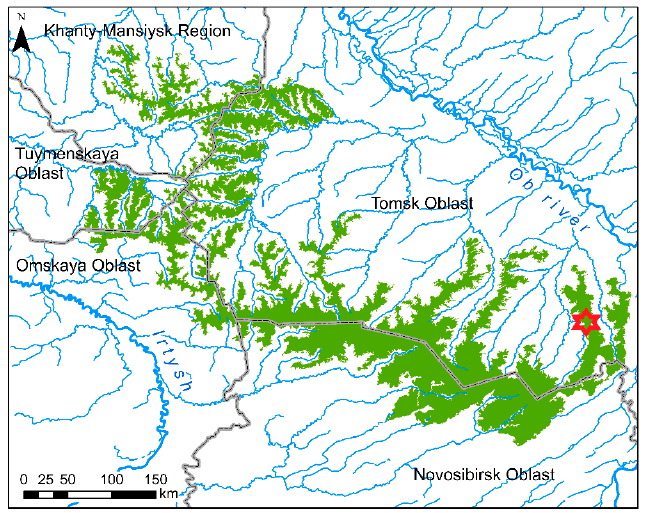
Figure 1. Location of the study area (red asterisk) within the Great Vasyugan Mire (highlighted in green).